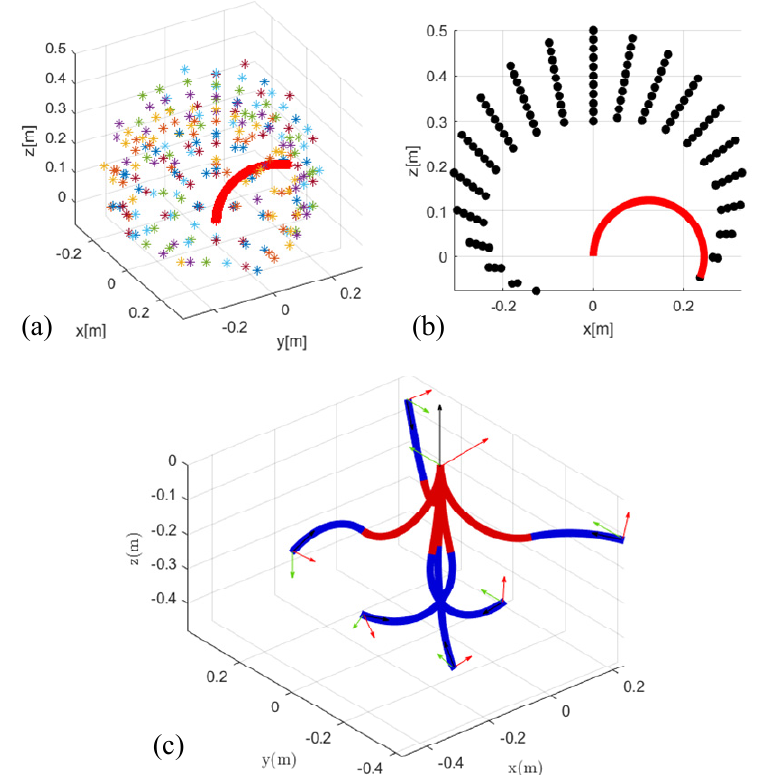
Figure 5. ( a ) The 3D working space of the single-section soft manipulator. ( b ) The bending state of the single-section soft manipulator in the XOZ plane. ( c ) The limit posture of the soft manipulator in space when the pressure on each soft unit of the two-section soft manipulator reaches the limit value (1 mpa).